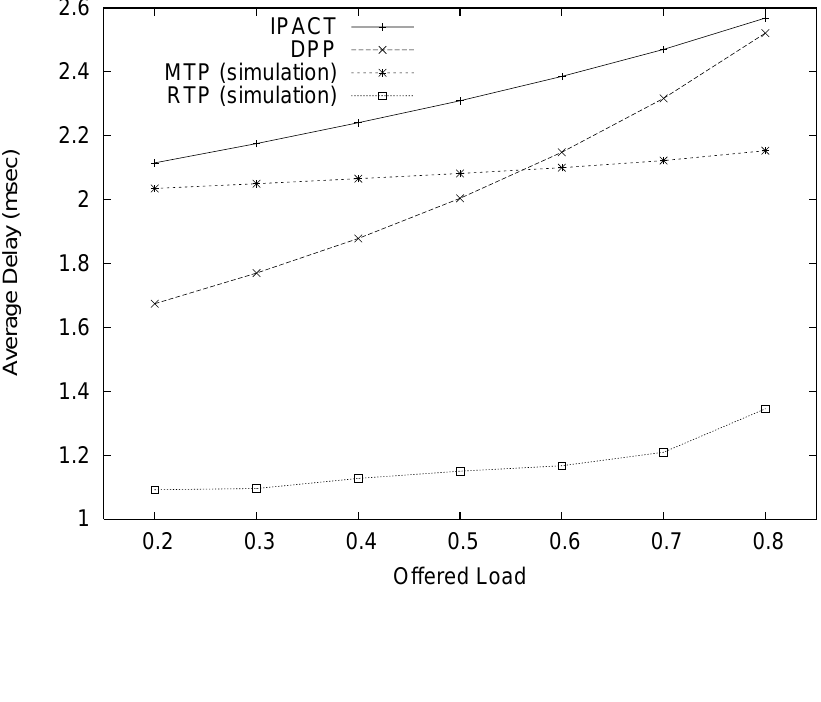
Figure 6. Delay performance